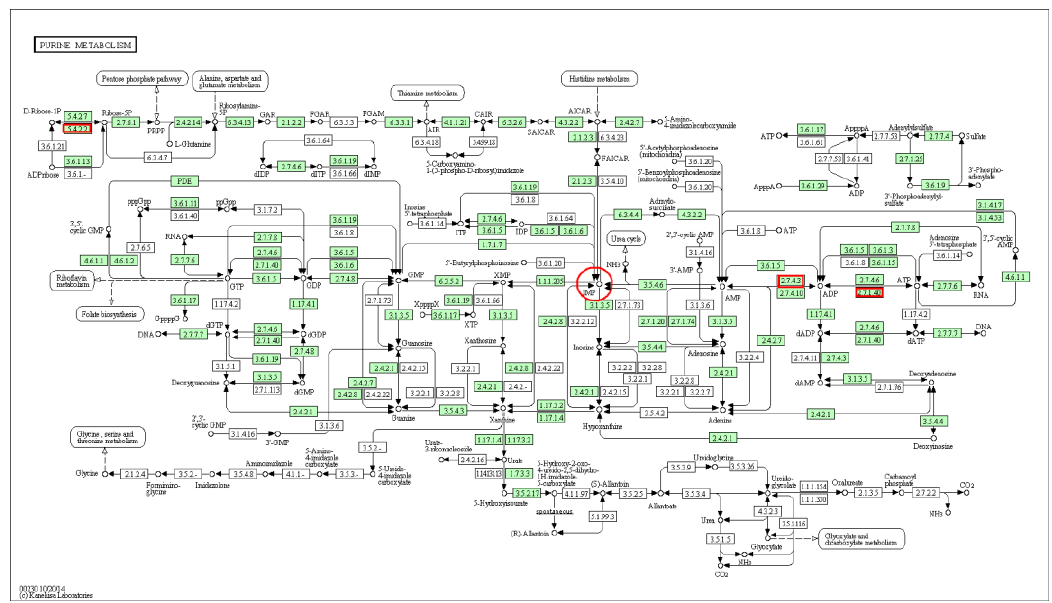
Figure 3. Location of differentially expressed genes (indicated by red boxes) in the purine metabolic pathway.